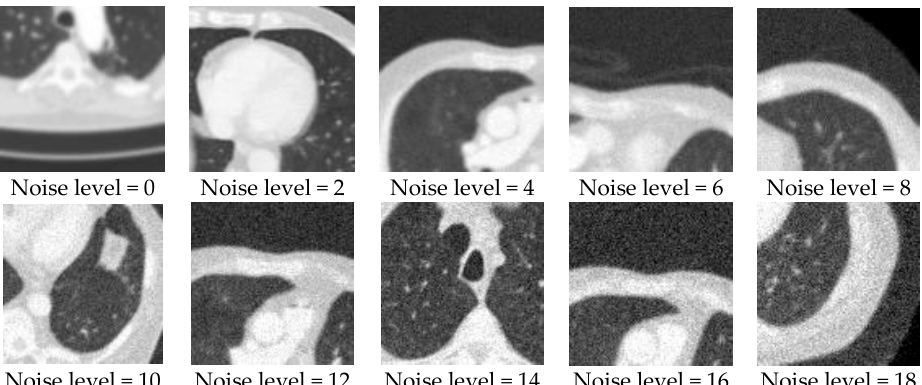
Figure 10. Sampled image patches with different noise levels as the dataset for the image noise estimation network.